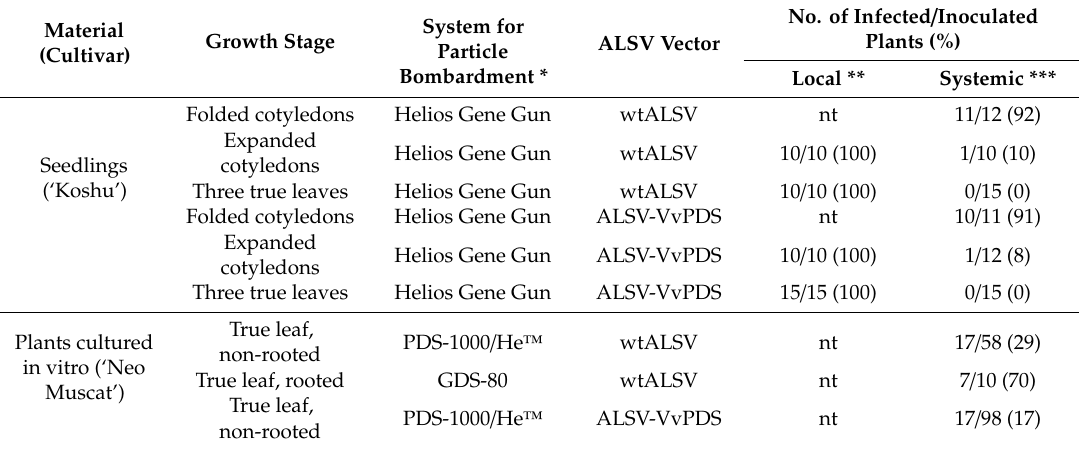
Table 1. Infection of wild-type ALSV (wtALSV) and ALSV-VvPDS to the seedlings and in vitro cultures of grapevine by particle